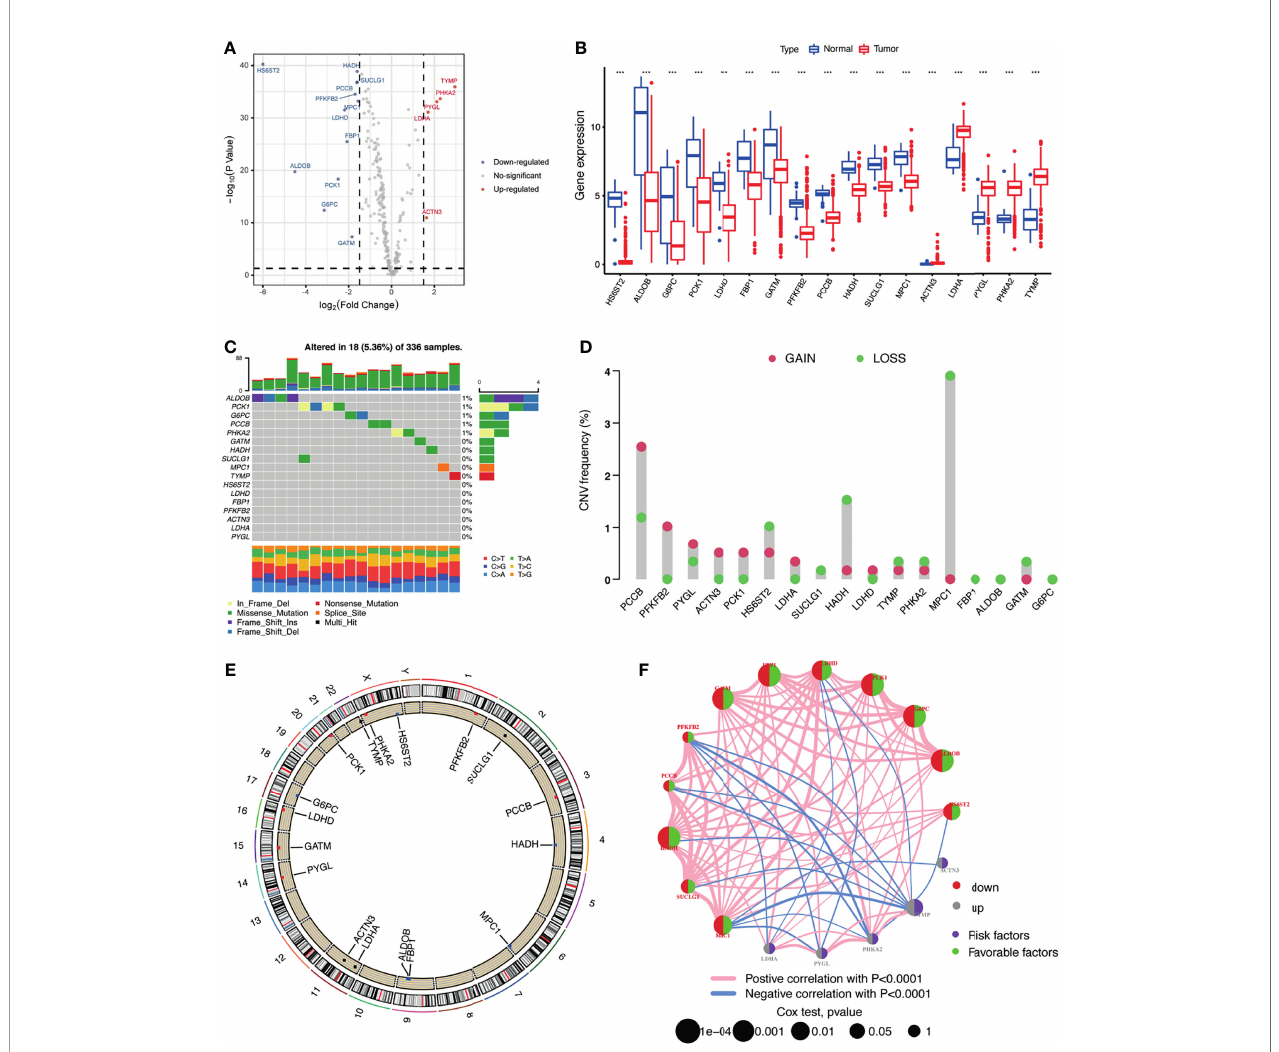
FIGURE 1 | Multi-omics landscape of the differentially expressed lactate-related genes (LRGs) in kidney renal clear cell carcinoma (KIRC). (A) Volcano plot of the signi fi cantly dysregulated LRGs in KIRC tissue. (B) Boxplot of the expressions of the 17 differentially expressed LRGs in the TCGA-KIRC cohort. (C) Mutation frequency of the 17 differentially expressed LRGs in 336 patients with KIRC. (D) Copy number variations (CNVs) of the 17 differentially expressed LRGs. (E) Locations of the CNV alterations of the 17 differentially expressed LRGs on 23 chromosomes. (F) Correlations and prognosis of the 17 differentially expressed LRGs in patients with KIRC. *** p <